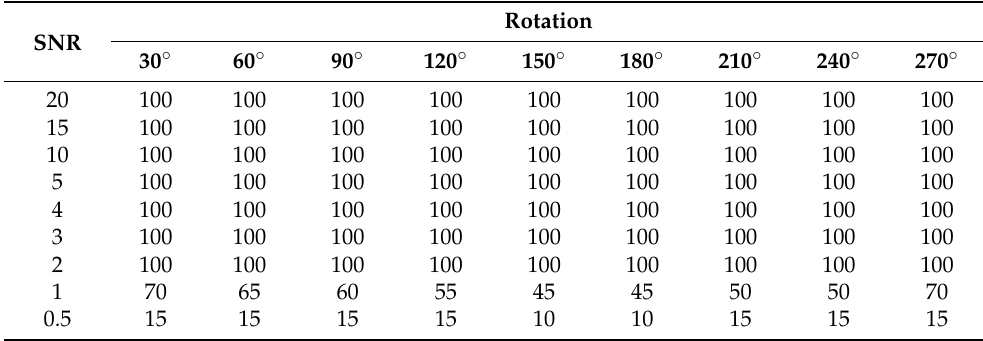
Table 11. The correct recognition rates for a combination of rotation angles and noise levels for the log-polar-FFT2 method for the 2D aircraft dataset.